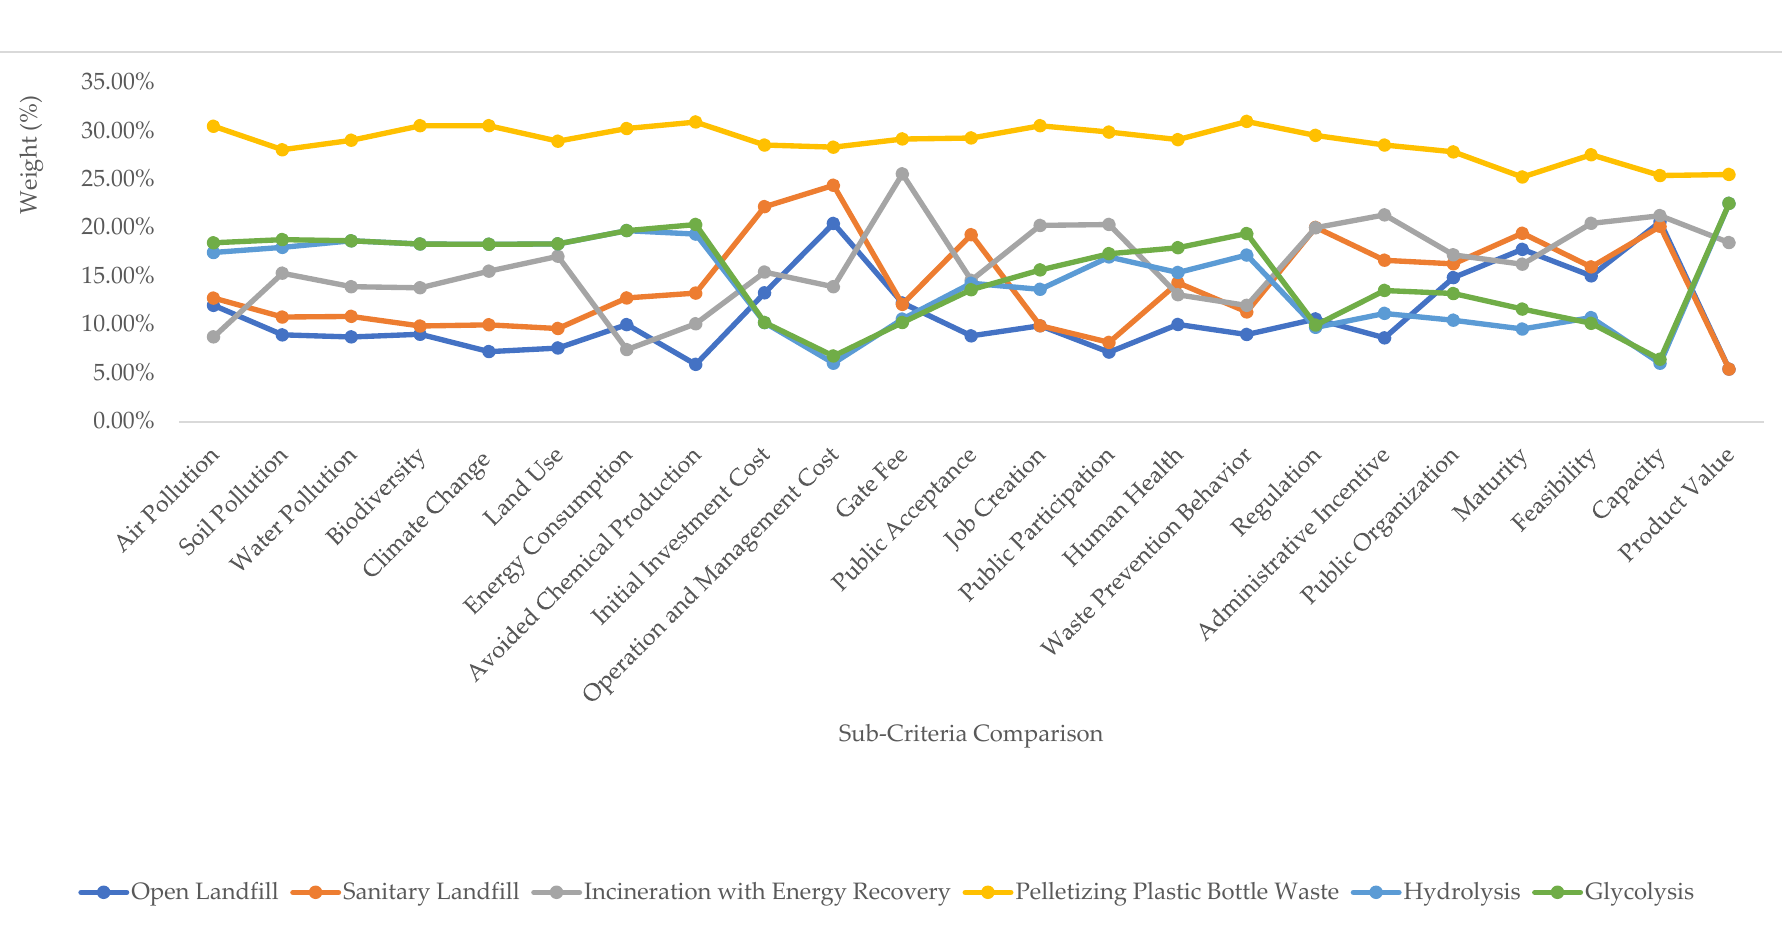
Figure 5. Expert sub-criteria judgment results for the alternatives (%).